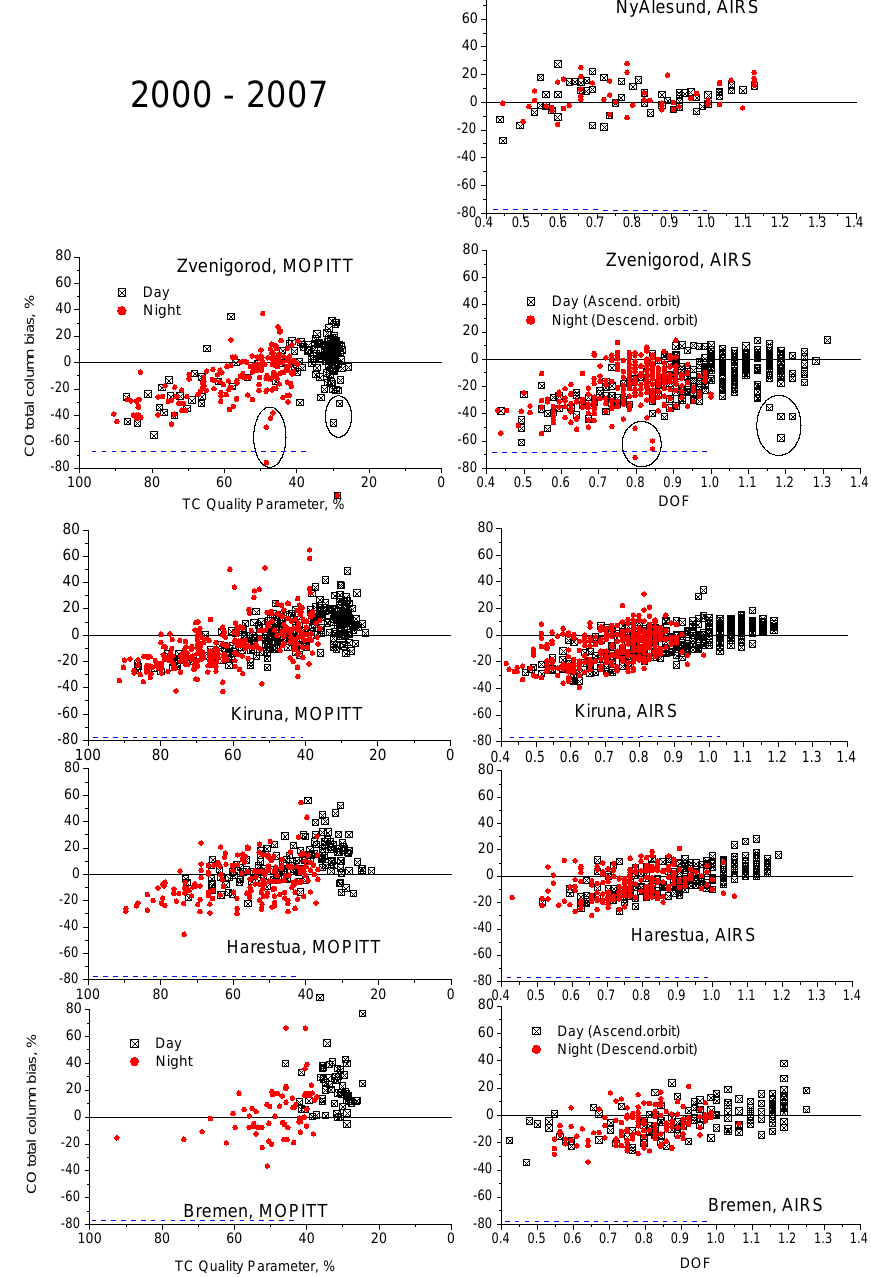
Fig. 2a. MOPITT and AIRS CO TC daily deviations from ground truth (in another words, satellite minus FTS) plotted as a function of information content. Total Column Quality Parameter (TCQP) for MOPITT (note a reverse scale) is the air pressure weighted means of the Profile Percent A priori determined for every grid cell (Yurganov et al., 2008). DOF for AIRS is the number of Degrees of Freedom of the retrieval (McMillan et al., 2009). Encircled symbols correspond to a period of peat fires in August–September 2002 around Zvenigorod (see discussion in the